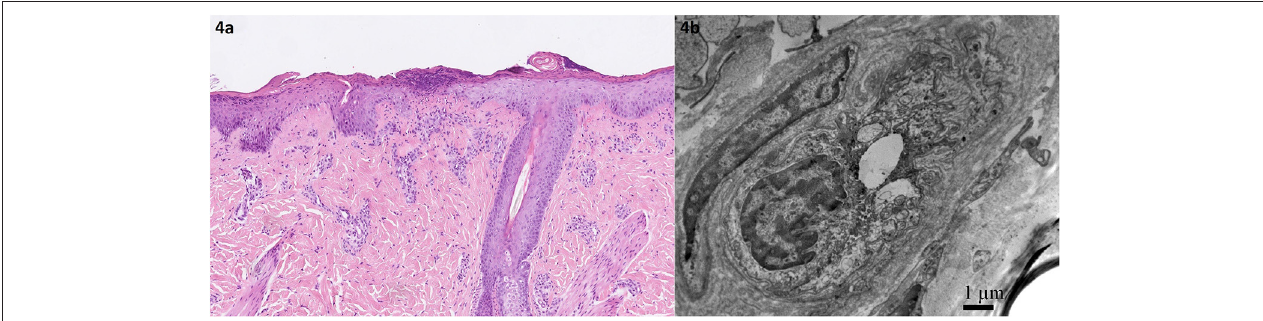
FIGURE 4 | Histopathology of the skin efflorescence in the sacral area. (a) Focal epidermal necrosis is present in the center. Note the pronounced underlying small vessels with swollen endothelial cells in the papillary dermis. HE, original magnification, × 6. (b) Electron microscopy of swollen endothelial cells obliterating the lumen of the aforementioned small